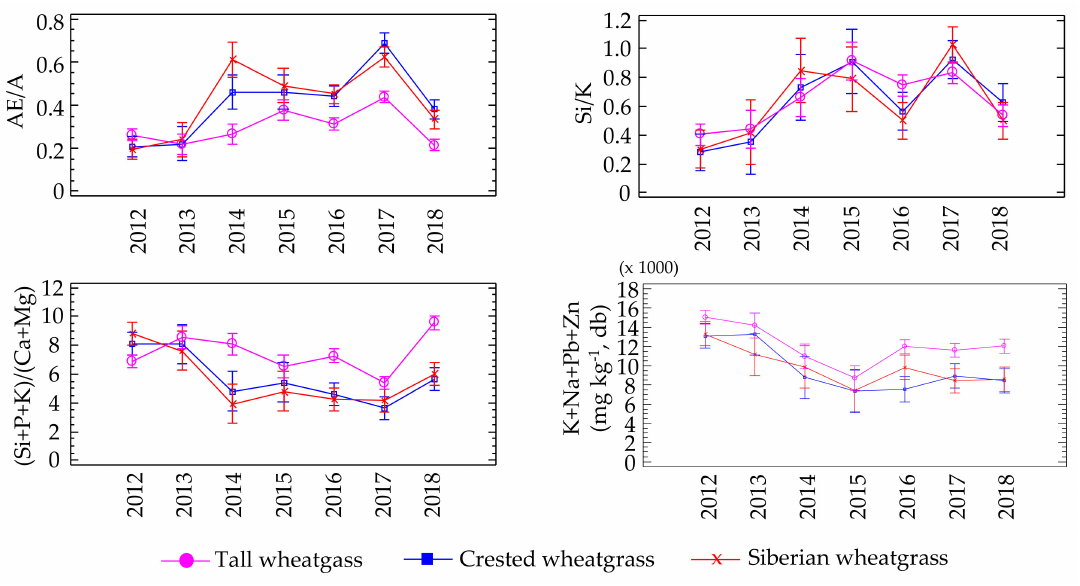
Figure 6. Fuel indices across species and years for the biomass cultivated in the CS fields. Means and Fisher´s LSD interaction